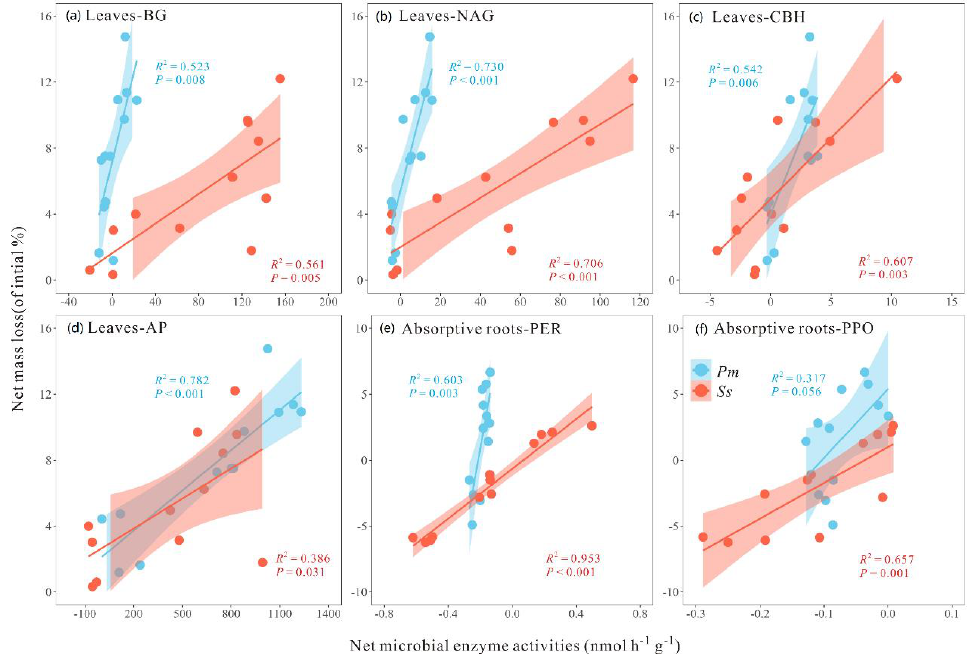
Figure 7. Relationships between the net microbial enzyme activity and net mass loss for decomposing leaves and absorptive roots in the 3-year stage of decomposition. ‘Net values’ were calculated by deducting the enzyme activity or mass loss of the control treatment from that of the nutrient-addition treatments. Different nutrient treatments were pooled, n = 12, p < 0.05. BG, β -1,4-glucosidase; NAG, β -1,4-N-acetylglucosaminidase; CBH, cellobiohydrolase; AP, acid phosphatase; PER, peroxidase; PPO, polyphenol oxidase.